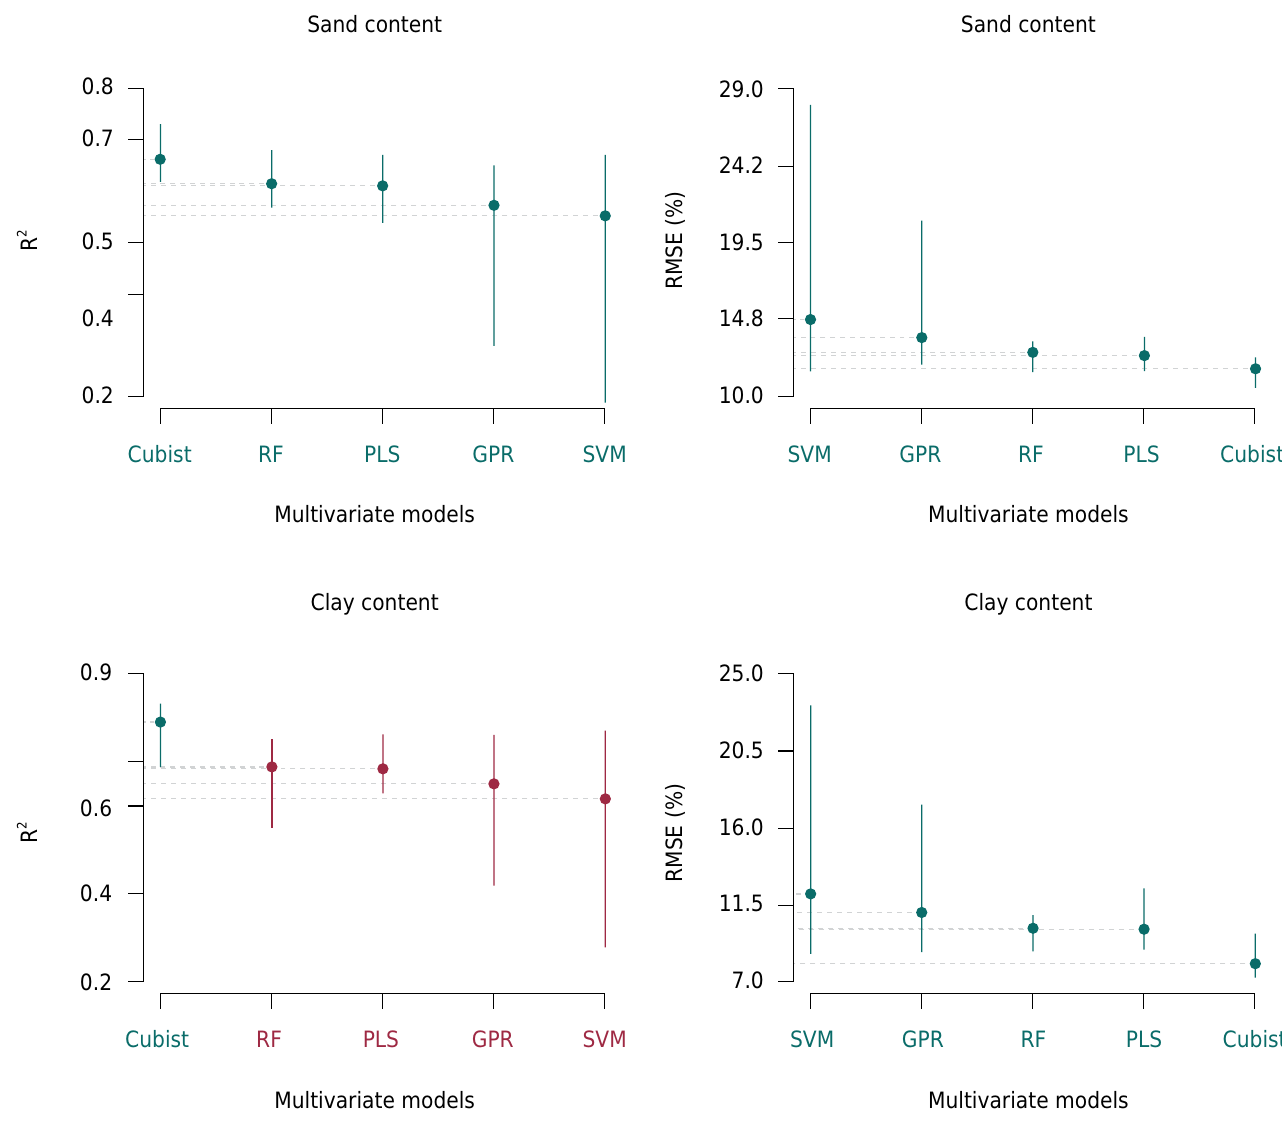
Figure 4. Statistical difference between multivariate methods resulted by Scott Knott test (significance level of 10 %). The mean, maximum, and minimum values of R 2 and RMSE for each method applied for sand and clay